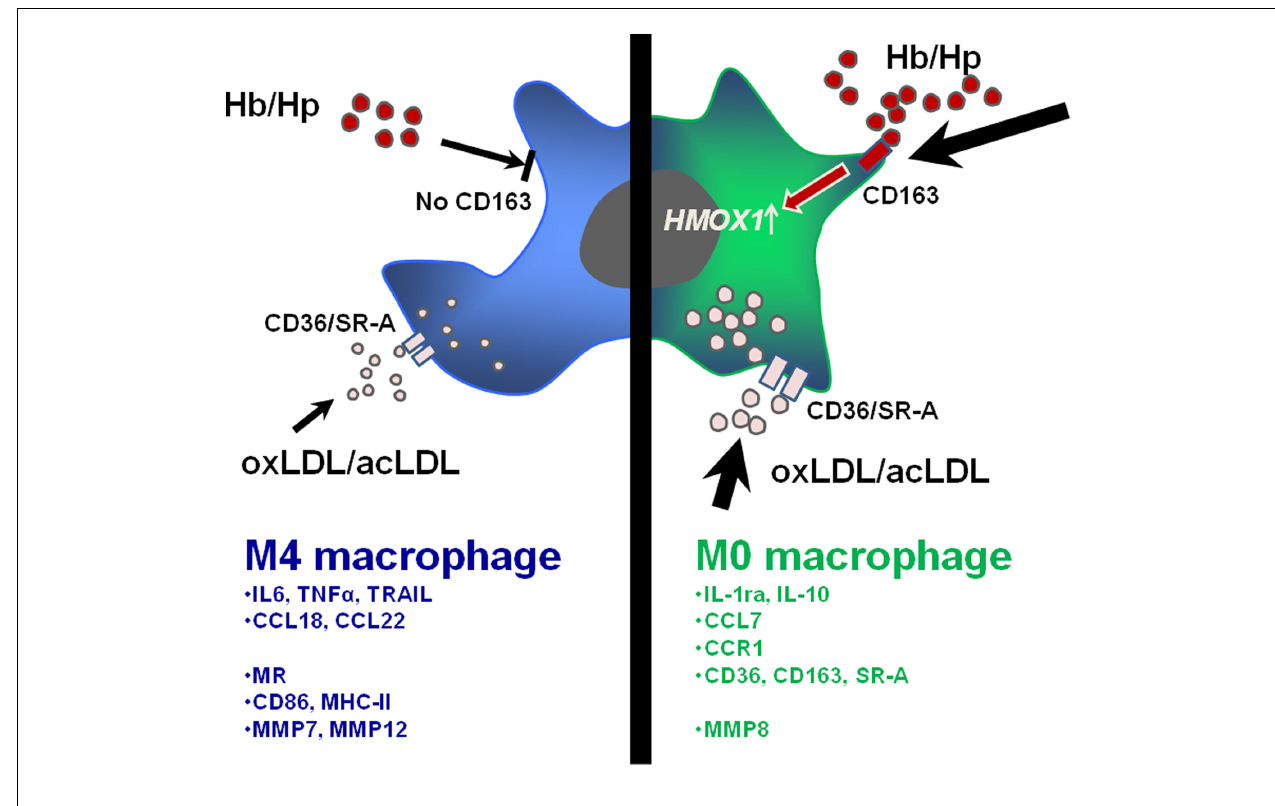
express lover levels of scavenger receptors CD36/SR-A leading to fewer uptake of oxidized or acetylated low density lipoprotein (oxLDL/acLDL) as compared to M0 macrophages.The lower part of the figure indicates a selection of relevant cytokines, chemokines, chemokine receptors, surface receptors, molecule involved inT cell activation, and matrix metalloproteinases overexpressed in M4 or M0 macrophages